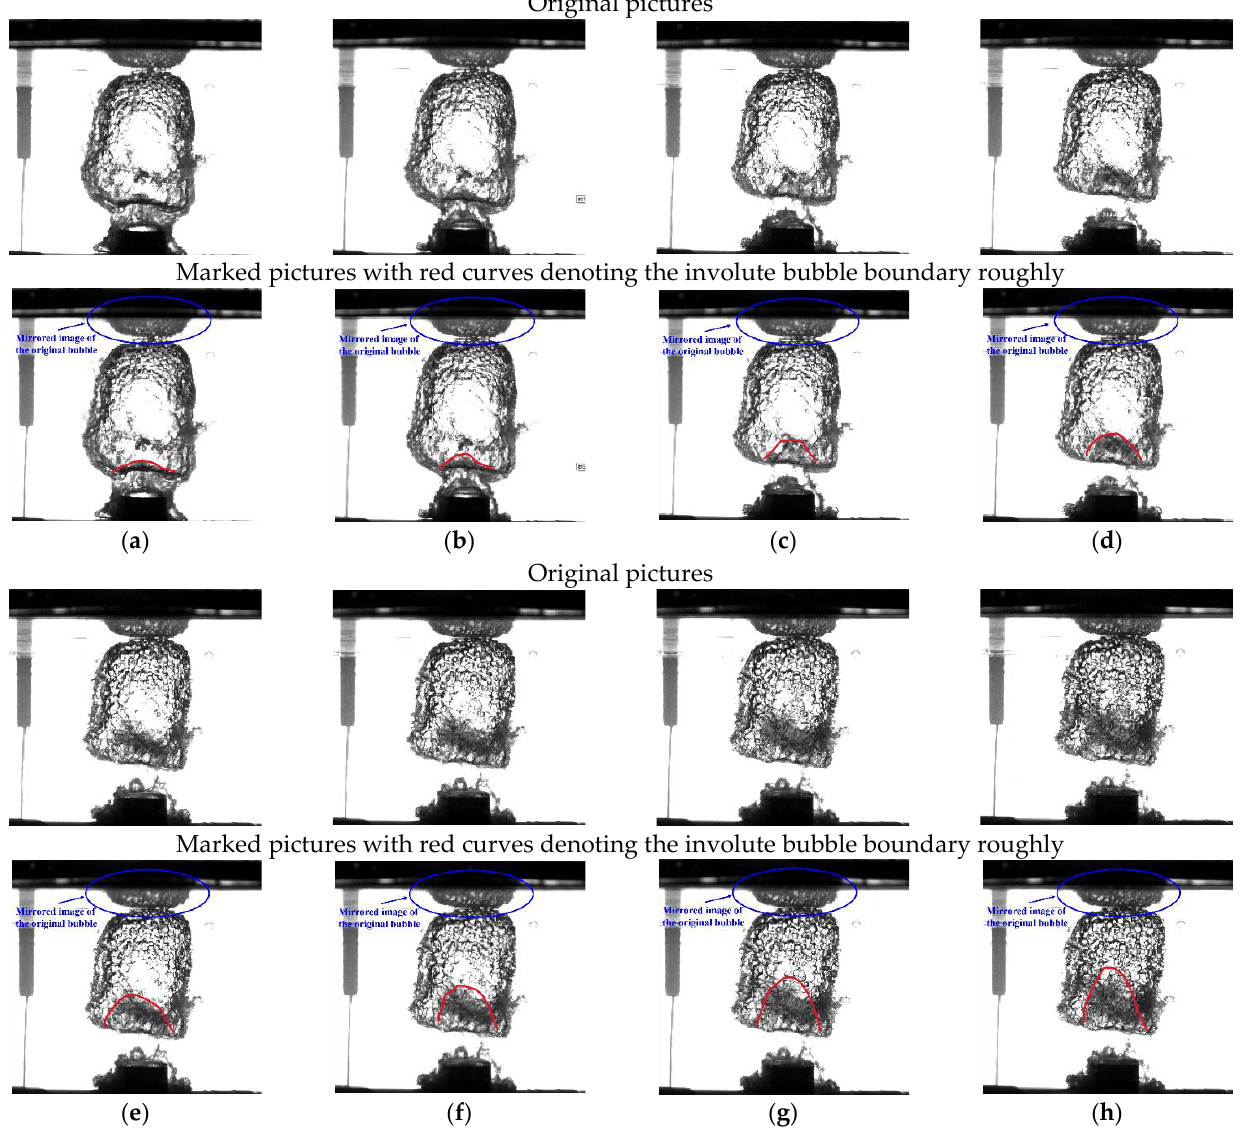
Figure A1. Images of the jet evolution of the bubble in Figure 6. ( a ) t = 7.95 ms, ( b ) t = 8.15 ms, ( c ) t = 8.35 ms, ( d ) t = 8.50 ms, ( e ) t = 8.65 ms, ( f ) t = 8.75 ms, ( g ) t = 8.85 ms, ( h ) t = 8.95 ms.